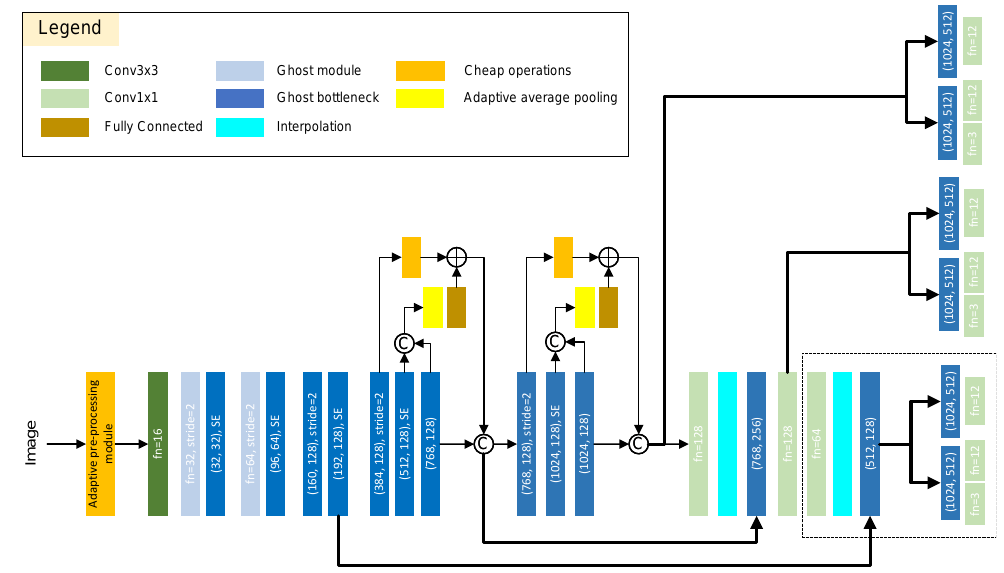
Figure 6. The schematic diagram of the ULO and ULO Tiny architectures. In the newly proposed networks, Ghost modules, decoupled head, and adaptive pre-processing module are used. The difference in structure between ULO Tiny and ULO is that ULO Tiny does not contain the structure in the dotted box to reduce the network parameters further. Batch normalizations and activations are omitted for simplicity. Better viewed in zoom and